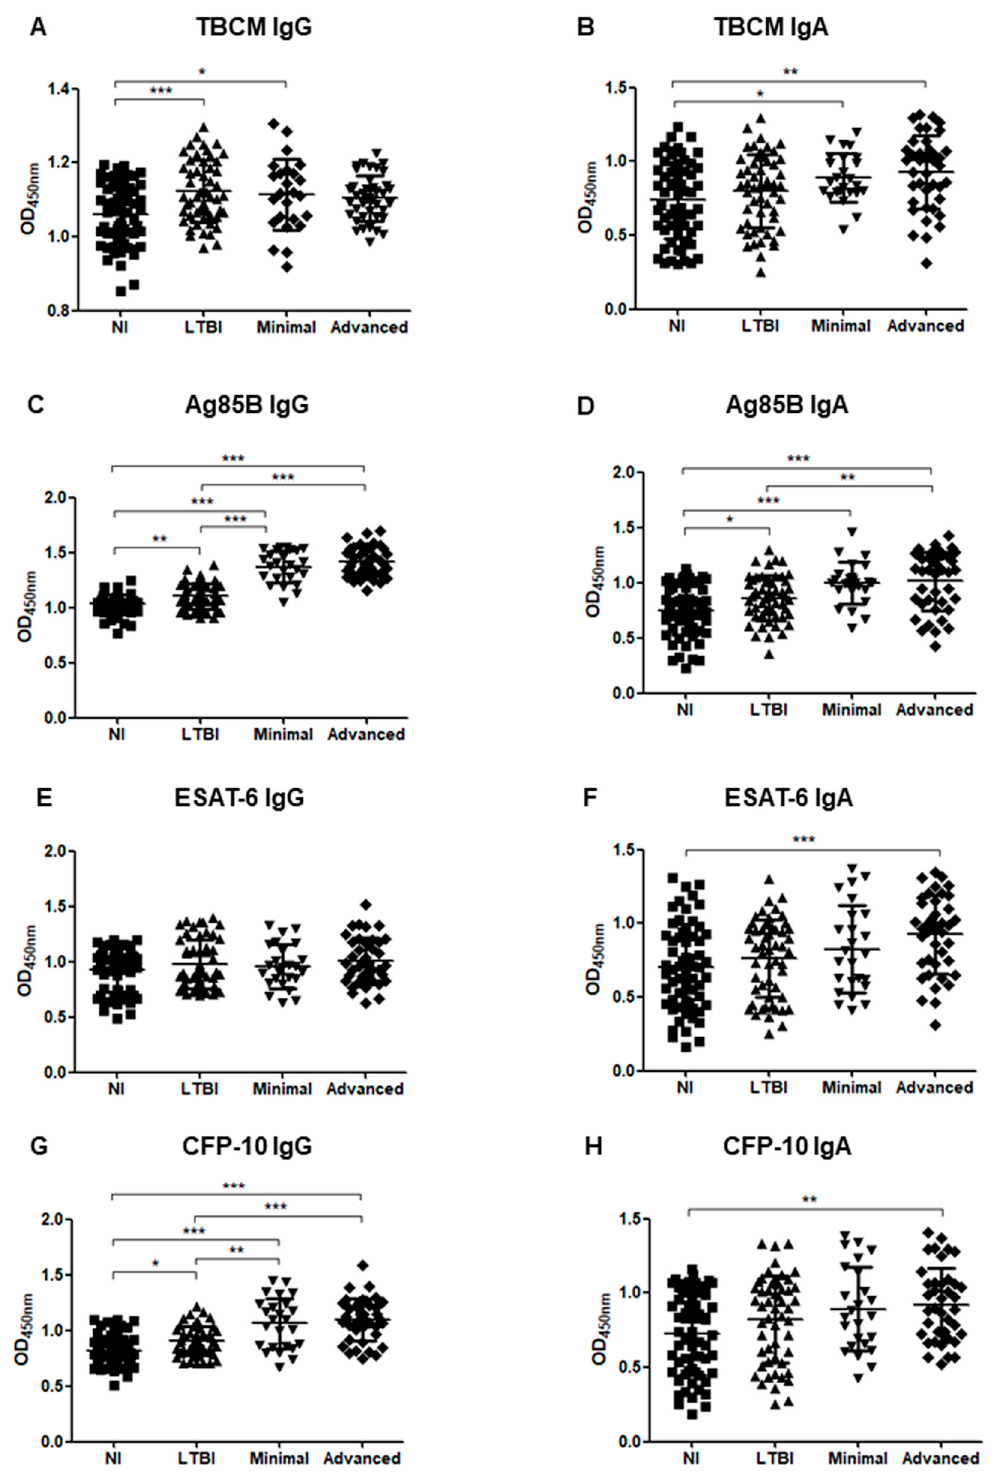
Figure 3. The optical density (OD) values of the anti-TBCM IgG ( A ), anti-TBCM IgA ( B ), anti-Ag85B IgG ( C ), anti-Ag85B IgA ( D ), anti-ESAT-6 IgG ( E ), anti-ESAT-6 IgA ( F ), anti-CFP-10 IgG ( G ), and anti-CFP-10 IgA ( H ) serodiagnosis assays for the comparison of 25 minimal tuberculosis, 40 advanced tuberculosis, 53 latent tuberculosis infection patients (LTBI), and 62 non-infected individuals (NI). Each dot represents the values obtained from individual subjects, and horizontal bars indicate the average values. Groups were compared by one-way ANOVA with Bonferroni’s multiple comparisons. * p < 0.05; ** p < 0.01; *** p < 0.001.